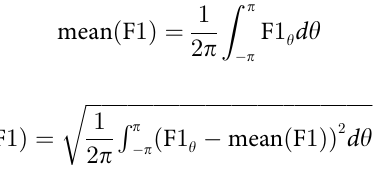
S1 Fig. Related to Fig 4, Recovery dynamics dependence on learning parameters under homeostatic plasticity. A-F: Final W / W (top) and minimum number of trials for W to Exc inh Exc reach up to about 1% from perfect tuning (bottom) obtained by varying target rate r (A), 0 learning speed α (B), perturbation strength p (C), W (D), mean input strengths c (E), and by inh varying α and r together while α r is fixed (F). Final W / W was obtained by taking the 0 0 Exc inh mean (red curve) and standard deviation (shaded area) over 500 trials after reaching to the steady state. The final W / W is affected by r , W , and c (A,D,E). Note that the effect of Exc inh 0 inh or c (D,E) can be reproduced by varying α and r together as derived analytically (F; W inh 0 Methods). On the other hand, varying α alone (B) or p (C) only affect the recovery speed in the opposite direction. r = 50, α = 4 × 10 − 8 , W = c = 500 unless otherwise specified and α r = 0 inh 0 2 × 10 − 6 in F. Note different scales in Figs 4B and S1B where the horizontal axis in Fig 4B is in log scale to show a larger parameter range and that in S1B Fig here is in linear scale to be con- sistent with other panels. S2 Fig. Related to Fig 6, Elongation of time constant associated with each eigenvector simi- lar to Fourier modes under differential plasticity. A: Time scale of each Fourier mode. For each Fourier mode, a time constant was estimated by projecting population activity onto a sinusoid of different frequencies (Methods) and fitting the time course with exponential decay. The negative reciprocals of these time constants have good correspondence with the eigenval- ues shown in Fig 6D except for around the first 250 trials when the network transiently devi- ates from translation-invariance. B: Eigenvectors related to eigenvalues in Fig 6D during the evolution of learning dynamics. The real part of the eigenvectors corresponding to the first, third, and fifth leading eigenvalues is plotted (even ones omitted because of redundancy). After around 250 trials, the shape of the eigenvectors is close to sinusoids, suggesting restora- tion and maintenance of translation-invariance. S3 Fig. Related to Fig 7. Effects of changing learning speed and global perturbation strengths on recovered activity pattern under differential plasticity. Each panel is a snapshot of activity at the end of the delay period as in Fig 6B. The decoding error and spatial selectivity variability in Fig 7E and 7F were derived from these patterns. Note the color range twice as large as those in the main figures. S4 Fig. Related to Fig 8. Sensitivity of homeostatic plasticity on learning parameters in a spa- tially structured network. A-C: Effect of lower (A), higher target rates (B), and fast speed (C) under homeostatic plasticity. Top, middle and bottom rows show postsynaptic E-I